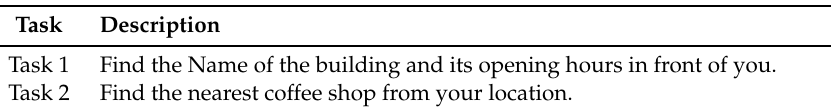
Table 2. Description of the easy